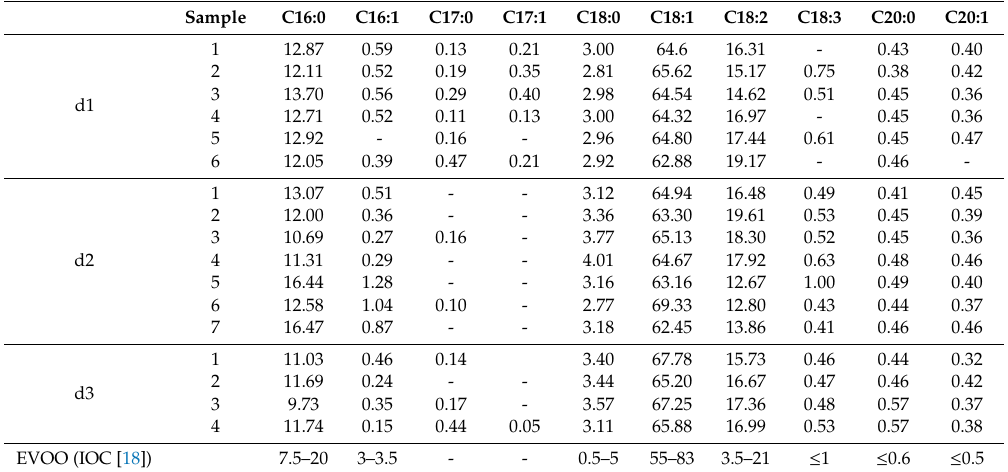
Table 2. Fatty acid composition of olive oil samples (% m / m methyl